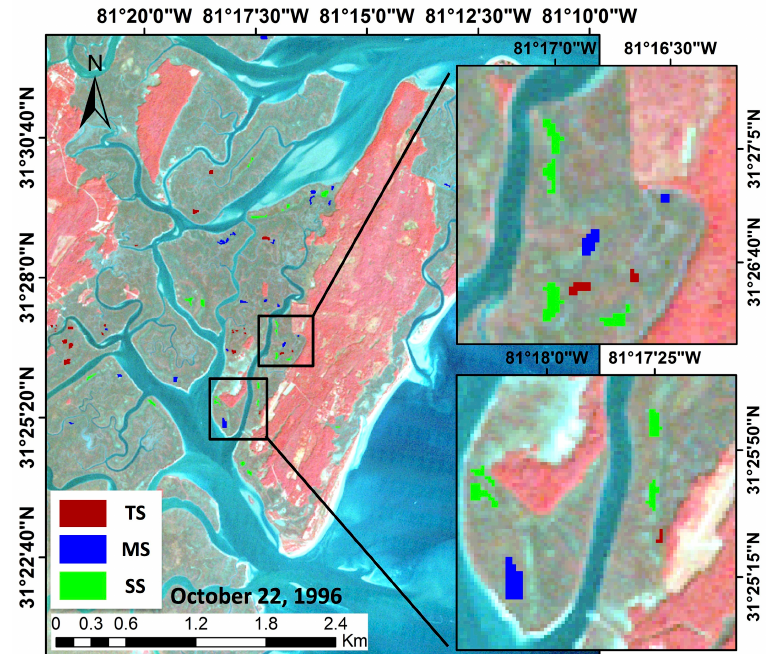
Figure 3. Landsat 5 color infrared image of Sapelo Island, GA and surrounding marshes highlighting polygon selection approach for extracting pixel clusters of different S. alterniflora size classes within our study site using Environment for Visualizing Images’ (ENVI) Region of Interest (ROI) procedure. Table 3. ENVI’s Region of Interest (ROI) tool was used to extract polygons across the three height classes of S. alterniflora . The table depicts number of polygons, total pixels, and area covered by each of the three height classes of S. alterniflora sampled for this